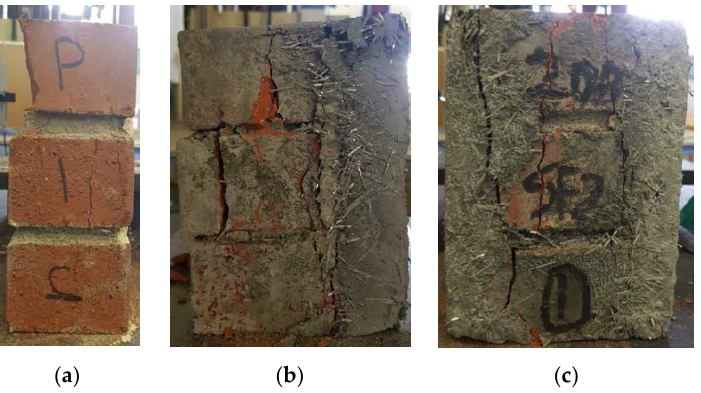
Figure 6. Damage state after termination of compression tests: ( a ) C-P; ( b ) C-SF-30S; ( c ) C-SF-30B.